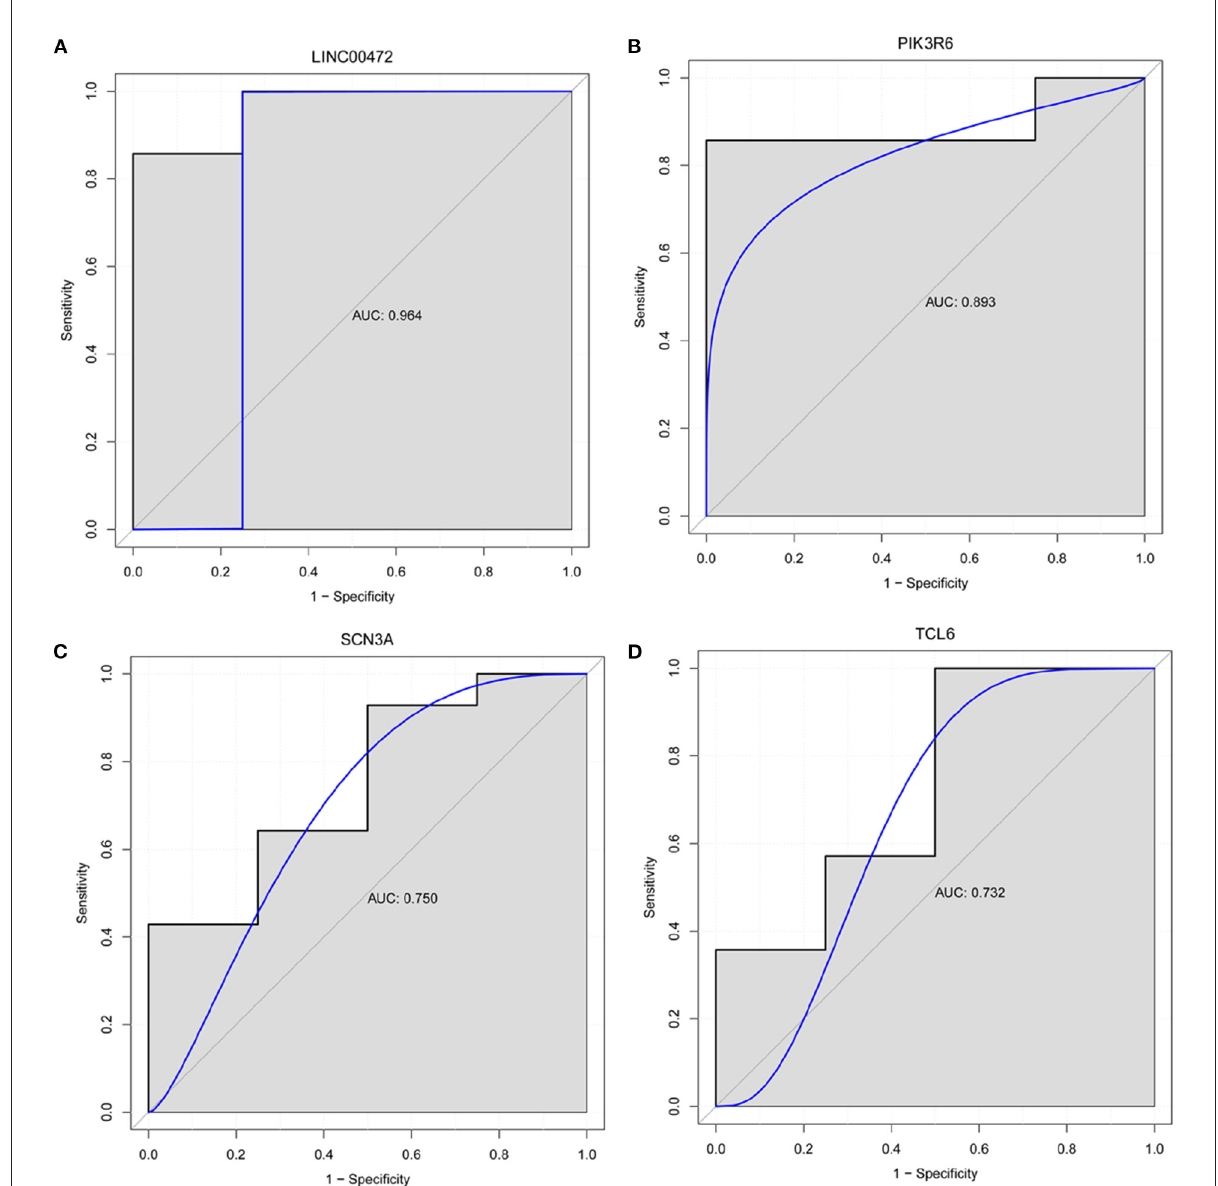
FIGURE7 Diagnostic analysis of LINC00472 (A) , PIK3R6 (B) , SCN3A (C) and TCL6 (D) . In ROC curve analysis, the AUC value of LINC00472, PIK3R6, SCN3A, and TCL6 was > 0.7. It is indicated that LINC00472, PIK3R6, SCN3A, and TCL6 may act as the potential gene markers in